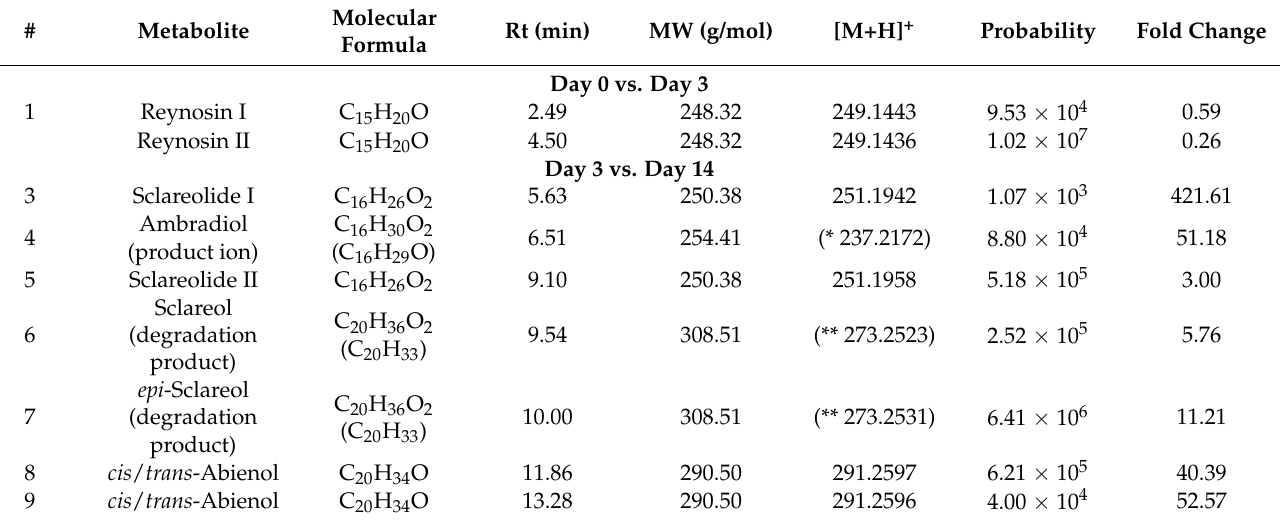
Table 1. List of annotated significant biomarker metabolites in extracts from sclareol-treated H. roseoniger grown in batch